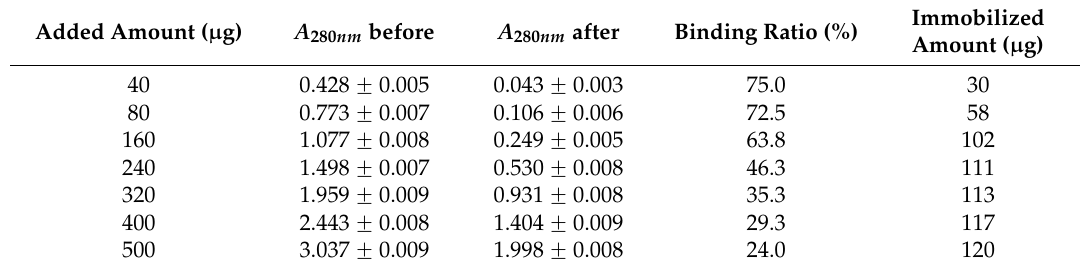
Table 1. Absorbance value of SPA solution before and after binding to magnetic nanoparticles ( n = 5).